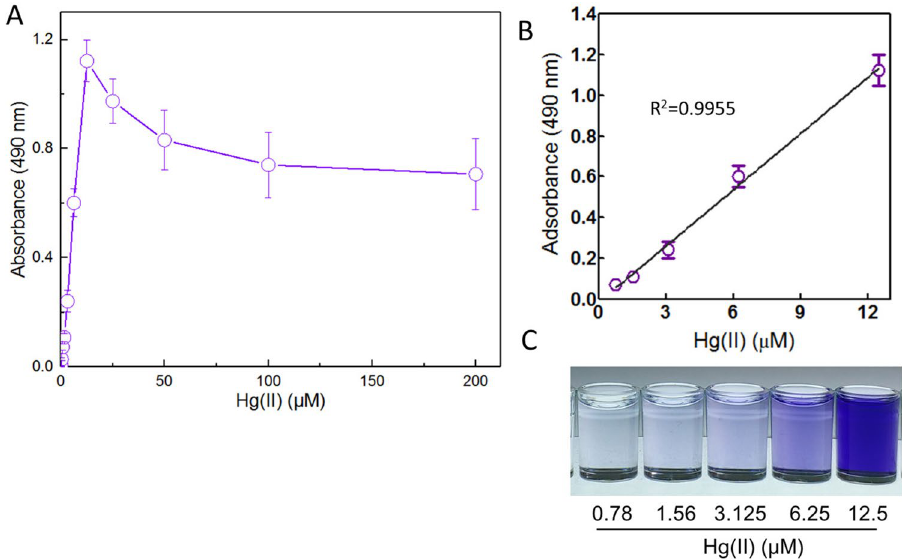
Figure 5. The response of exponential-phase culture of TOP10/pPmer-vio induced with increased concentrations of Hg(II). Exponential-phase culture of TOP10/pPmer-vio was induced with increased concentration of Hg(II) at 37 °C for 5 h. Whole-cell biosensor dose–response ( A ) and linear response ( B ) to Hg(II). The butanol phases containing violacein with 0.78–12.5 μM Hg(II) induction ( C ). Shown is one representative of three independent experiments with similar results. The background intensity (the absorbance at 490 nm with no Hg(II) exposure) was subtracted from each reading. The results are shown as the mean of three independent assays ± the standard deviation. The linear relationship was in the concentration range of 0.78–12.5 μM (R 2 =